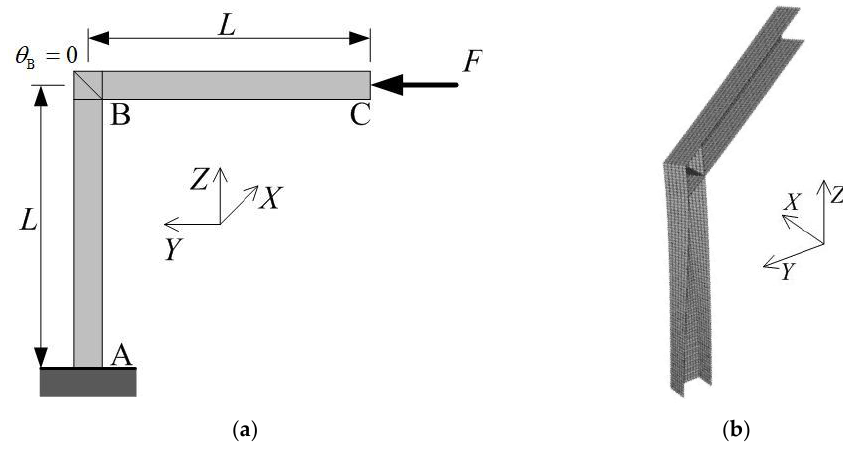
Figure 9. L-frame: ( a ) geometry and ( b ) lateral-torsional buckling mode.